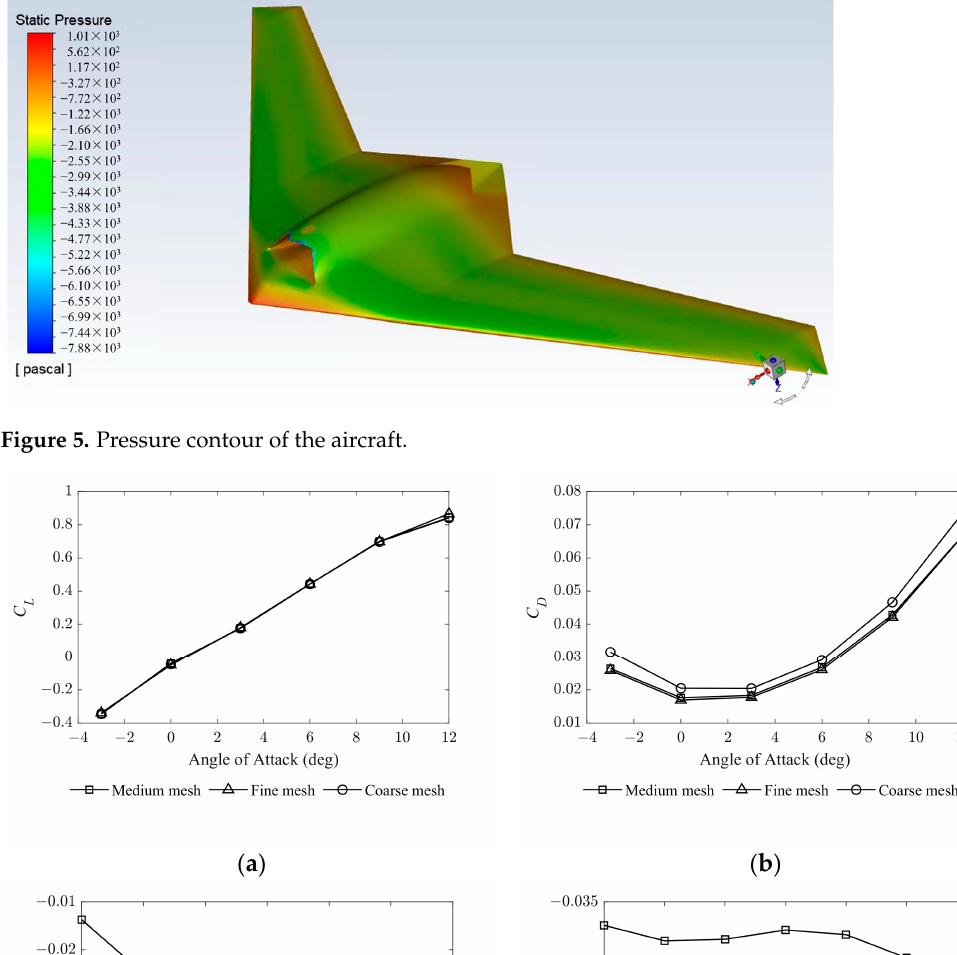
Figure 5. Pressure contour of the aircraft.